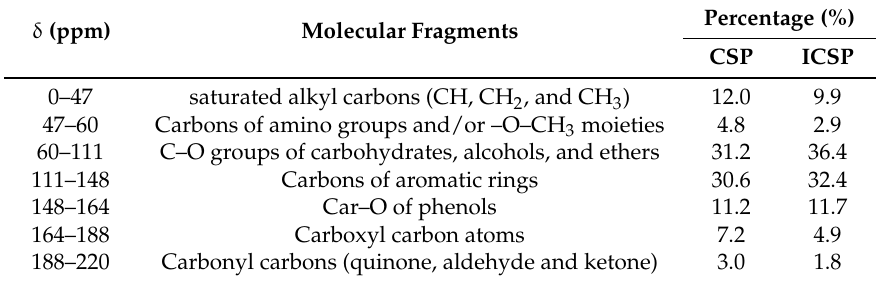
Table 2. Elemental compositions and molar ratios of CSP and ICSP.